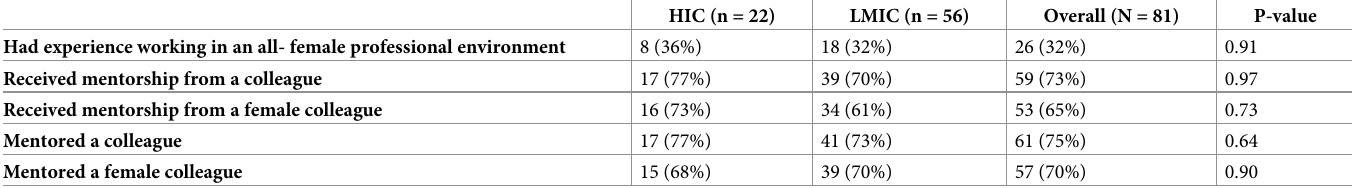
Table 2. Prior experience with female